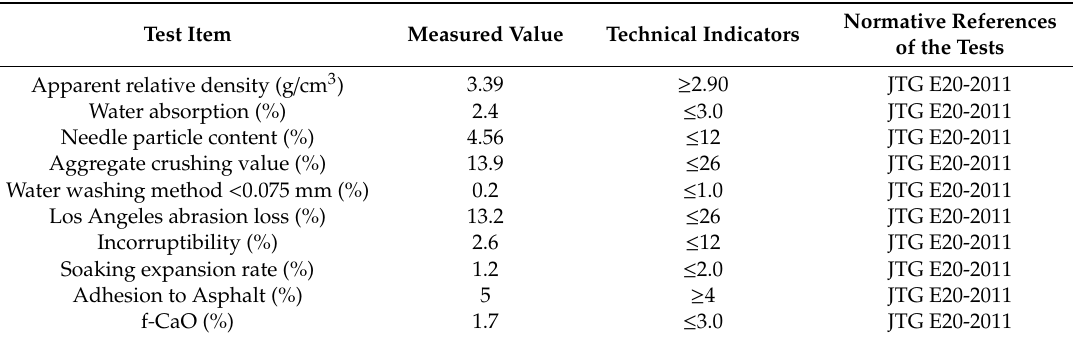
Table 4. Mechanical properties of steel